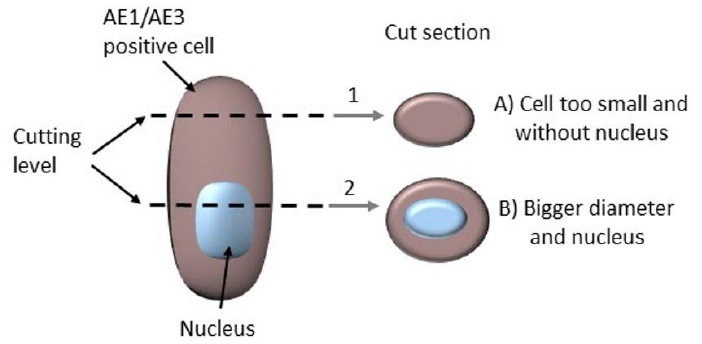
Figure 3. Scheme for cell truncation (for AE1/AE3). Cell components are stained differently: in